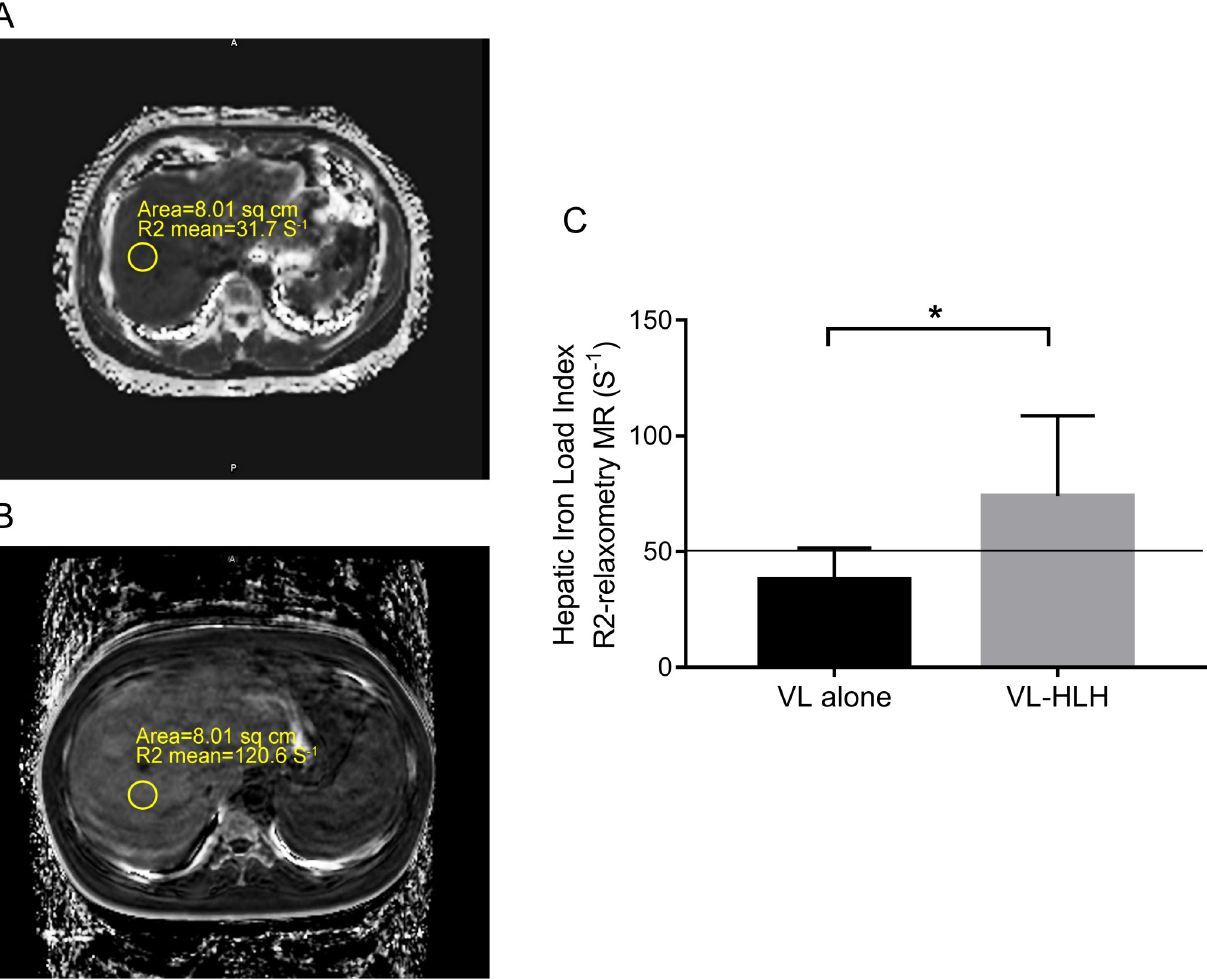
Fig 3. Hepatic iron load in VL alone and VL associated HLH patients with the magnetic resonance imaging. (A) Hepatic iron load for one of VL male patients was calculated by R2 relaxometry MR was 31.7 S -1 , below the threshold of 50 S -1 . (B) Hepatic iron load for one of VL associated HLH male patients was calculated by R2 relaxometry MR was 120.6 S -1 , far above the threshold of 50 S -1 . (C) Hepatic iron load statistical measurement in the VL and VL associated HLH groups (Normal range < 50 S -1 ). The chart indicated VL associated HLH patients suffered from high incidence of iron overload in the